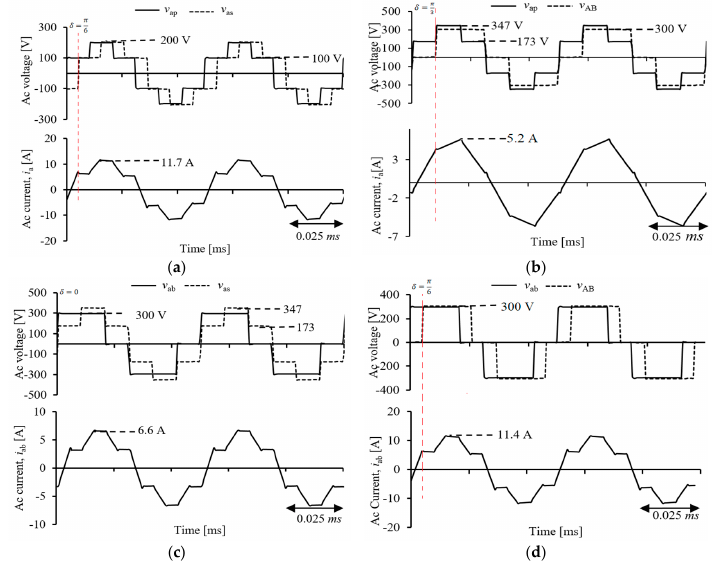
Figure 6. AC voltage and current waveforms of the 3P-BIDC in different transformer configurations operating in phase-shift modulation (PSM) at the rated power. ( a ) Yy. ( b ) Yd. ( c ) Dy. ( d ) Dd.